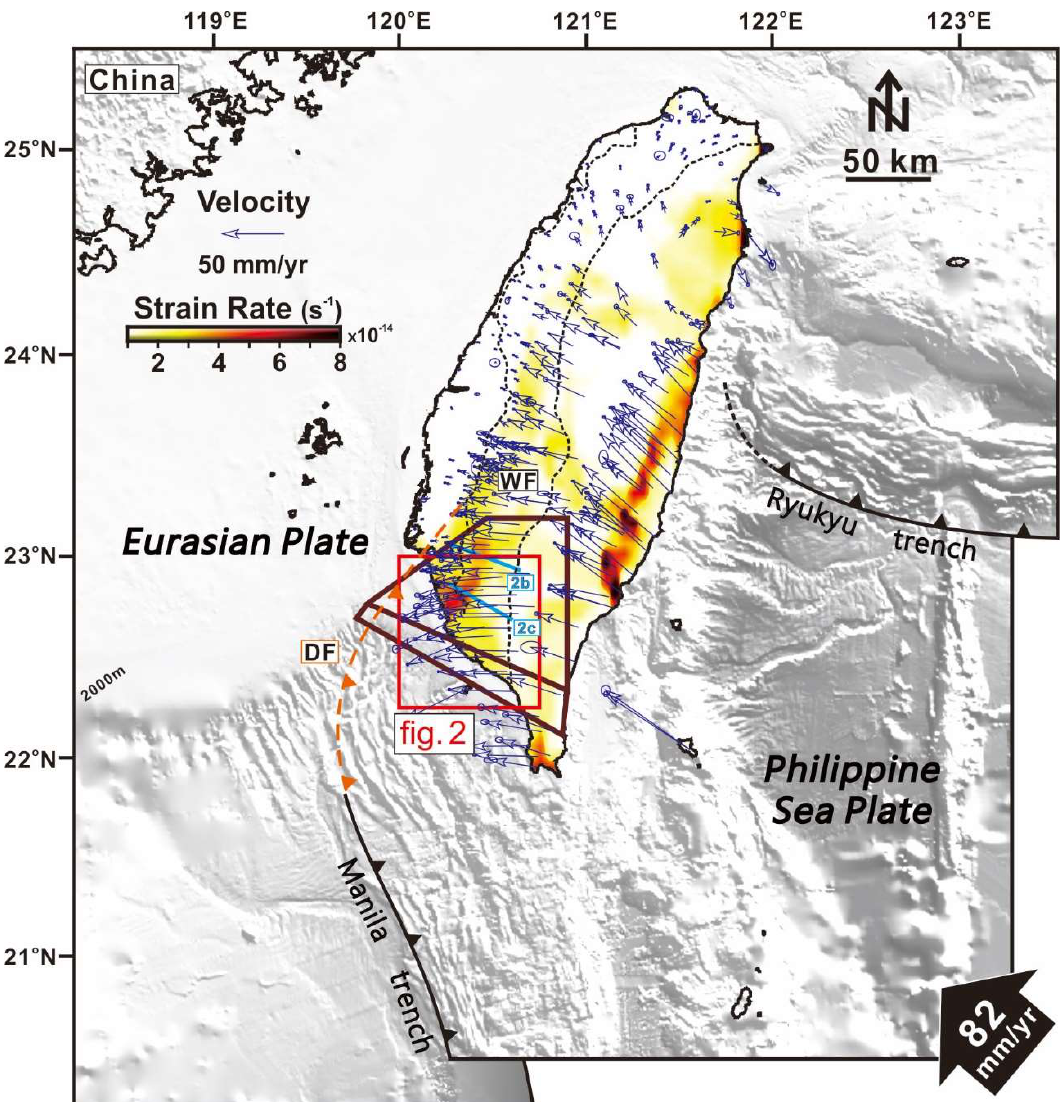
Figure 1. Major geological features of Taiwan. The blue arrows are the GPS velocity vectors [3]. The strain rate field is derived from the GPS data. The red rectangle is the spatial frame of Figure 2a. The bold blue lines indicate the location of the balanced cross-sections in Figure 2b,c. The brown box shows the location of the models in this study. DF: deformation front; WF: western foothills.